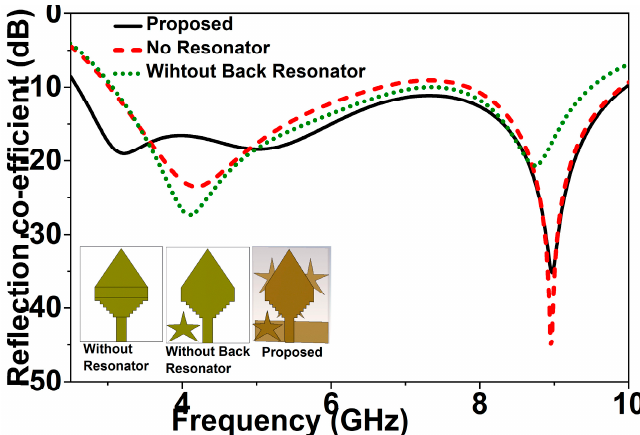
Figure 2. Effects of the parasitic resonator on reflection coefficient.